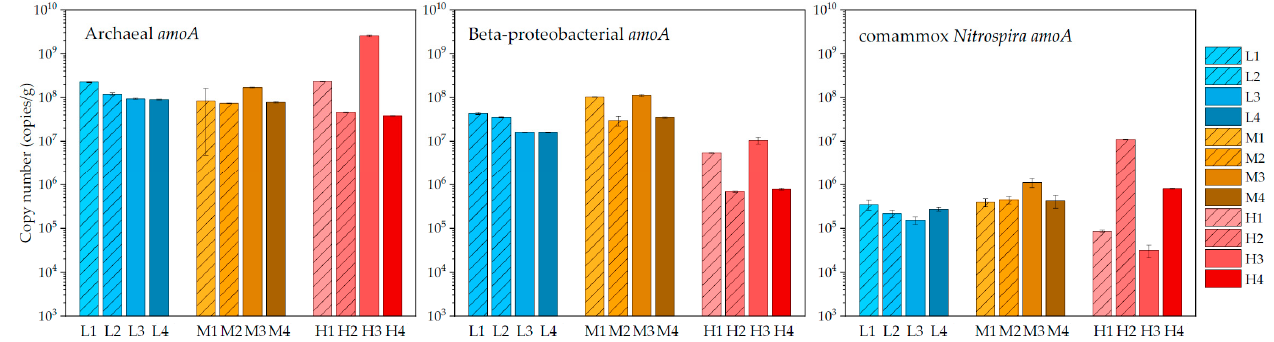
Figure 2. Quantitative result of amoA genes of nitrifying microorganisms biofilm samples. (( left ):